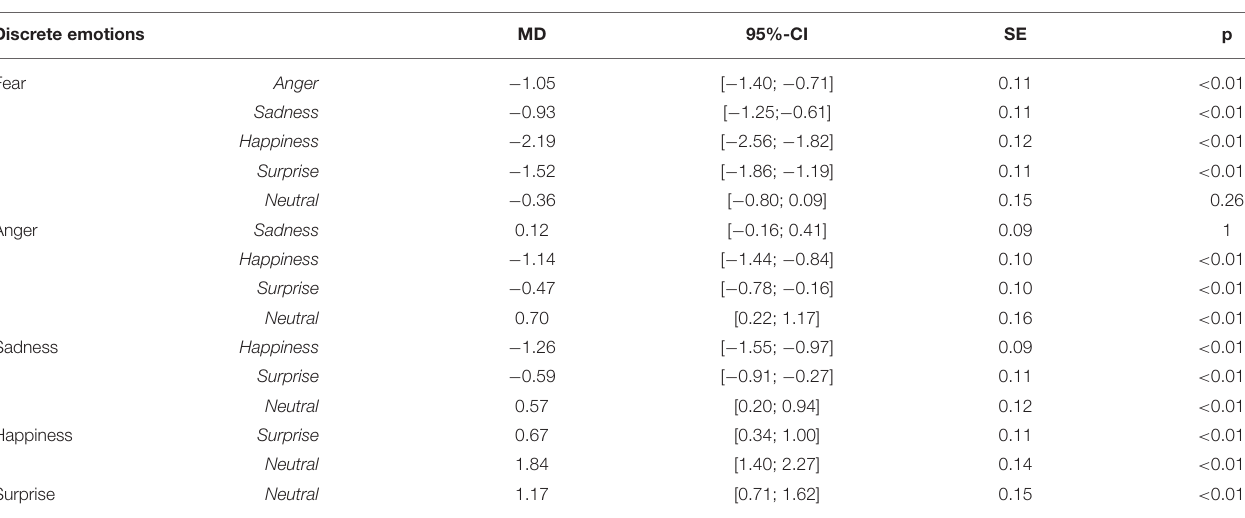
TABLE 1 | Mean Differences of emotionality scores for all discrete